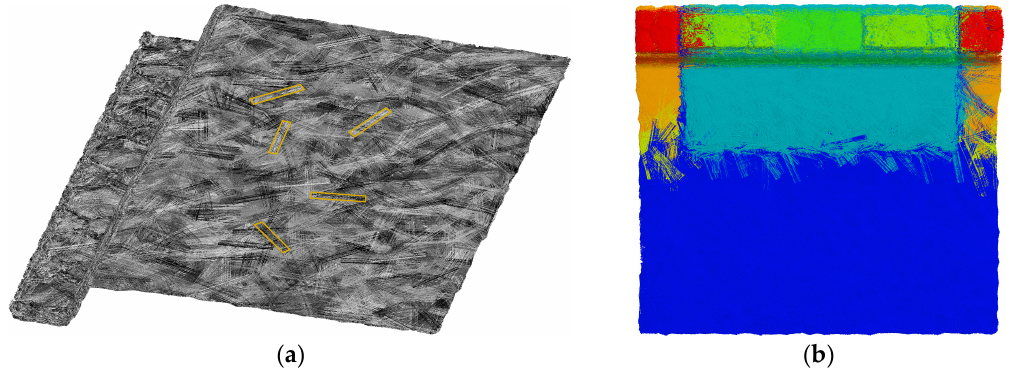
Figure 10. ( a ) Numerically modeled initial charge pattern for the ribbed hat profile part consisting of in-plane randomly oriented UD strands (5 UD strands are highlighted); ( b ) bottom view of the numerical charge definition where each charge package is colored differently for better discernibility.